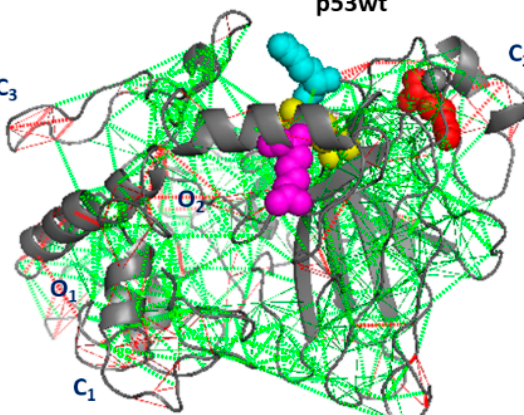
Figure 7. Frustration snapshot of p53wt.The level of frustration is represented by the colored scale: green represents minimal frustration and red high frustration. The residues submitted to punctual mutations and the Zn ion are represented as spheres.